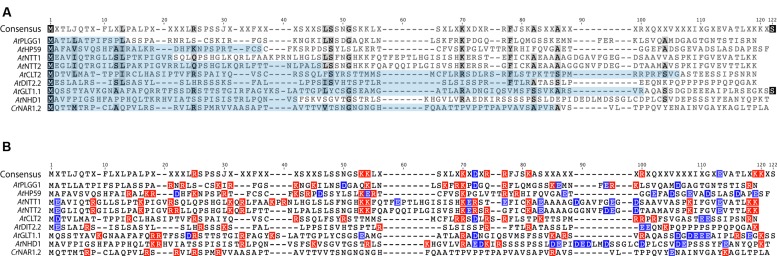
Alignment of the cTP + MPL regions of known A. thaliana IEM transporters and CrNAR1.2. (A) Alignment showing poor conservation of the cTP (pale blue) and MPL regions. (B) same alignment showing the distribution of positive (red) and negative (blue) charges. All A. thaliana proteins display an asymmetric charge distribution which is not present in CrNAR1.2. The end of each MPL was determined by the position of the first TMD, according to the prediction program SCAMPI-msa (see material and methods). Protein references are as follows: AtPLGG1 (AT1G32080), AtHP59 (AT5G59250), AtNTT1 (AT1G80300), AtGLT1 (AT5G16150), AtNTT2 (AT1G15500), AtDIT2;2 (AT5G64280), AtCLT2 (AT4G24460), AtNHD1 (AT3G19490) and CrNAR1.2 (AAT39454).